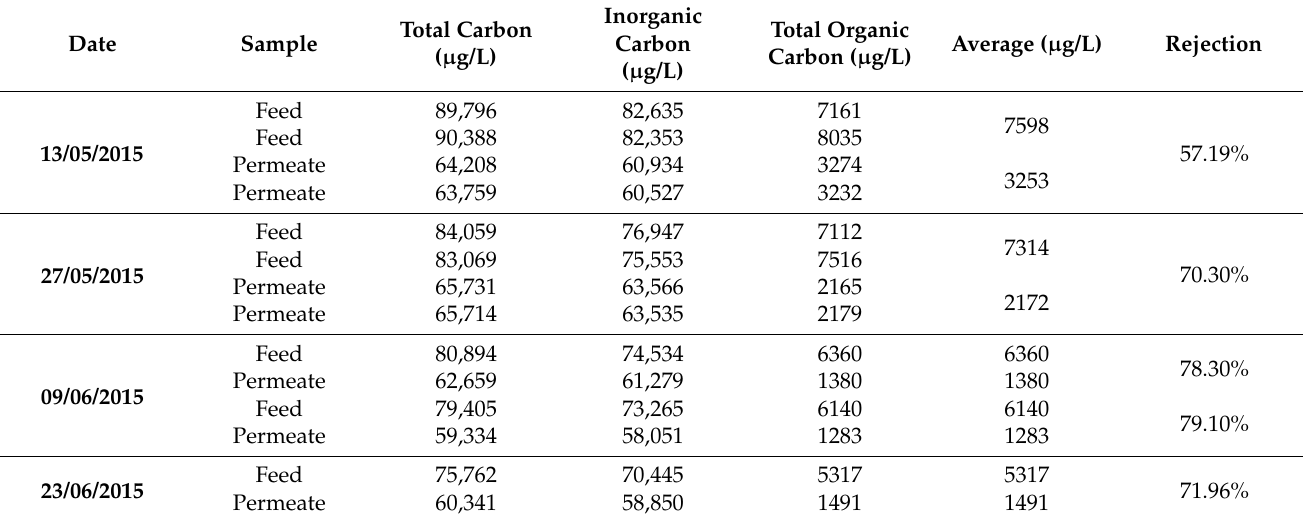
Table 7. Swansea University TOC data for NF